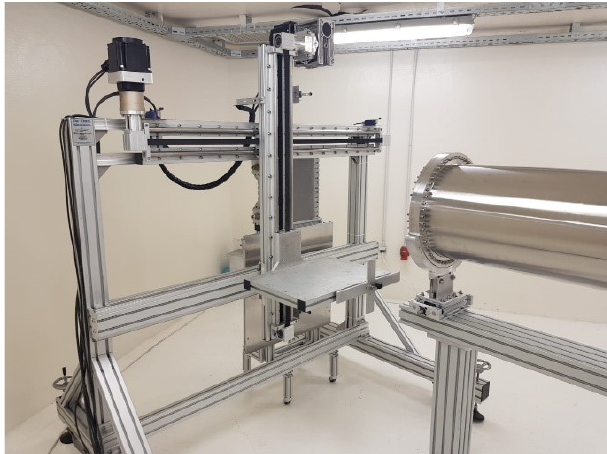
Fig. 17. Final design of the test table of METU-DBL, followed by the beam